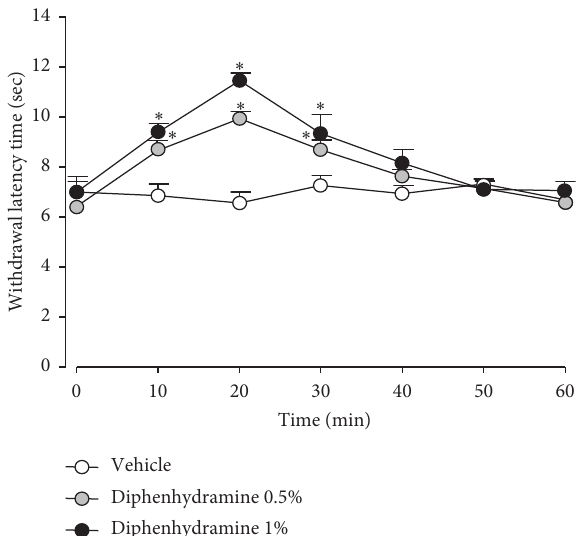
Figure 2: Comparison of the antinociceptive efficacy of 1% di- phenhydramine and 1% lidocaine. The subcutaneous injection of either agent significantly inhibited the withdrawal latency time compared with the vehicle treatment, but they were not statistically different from each other in producing this effect. The values shown are the mean ± SEM, and there were seven animals in each group. ∗ P < 0 . 05, vehicle vs. diphenhydramine or